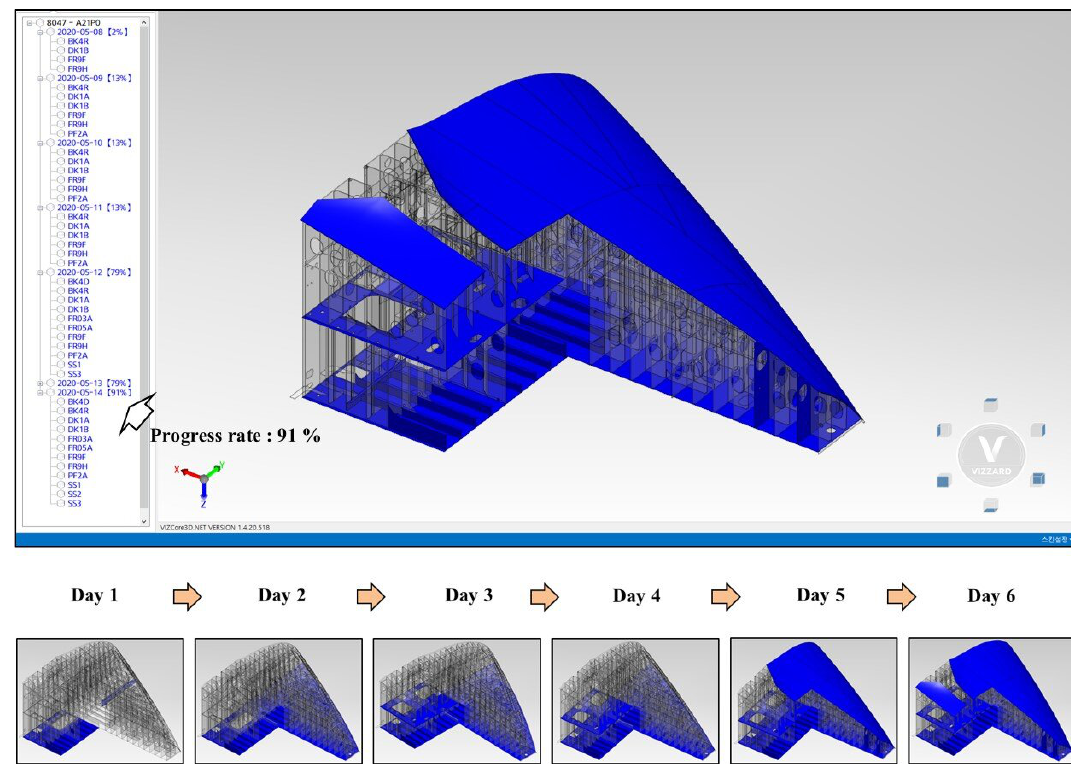
Figure 10. Visualization of mounting activity.